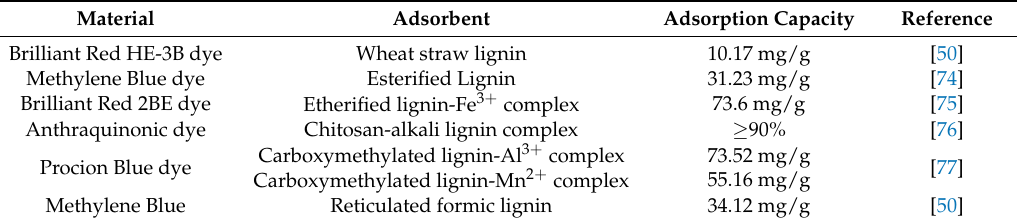
Table 4. Lignin as an adsorbent for dye